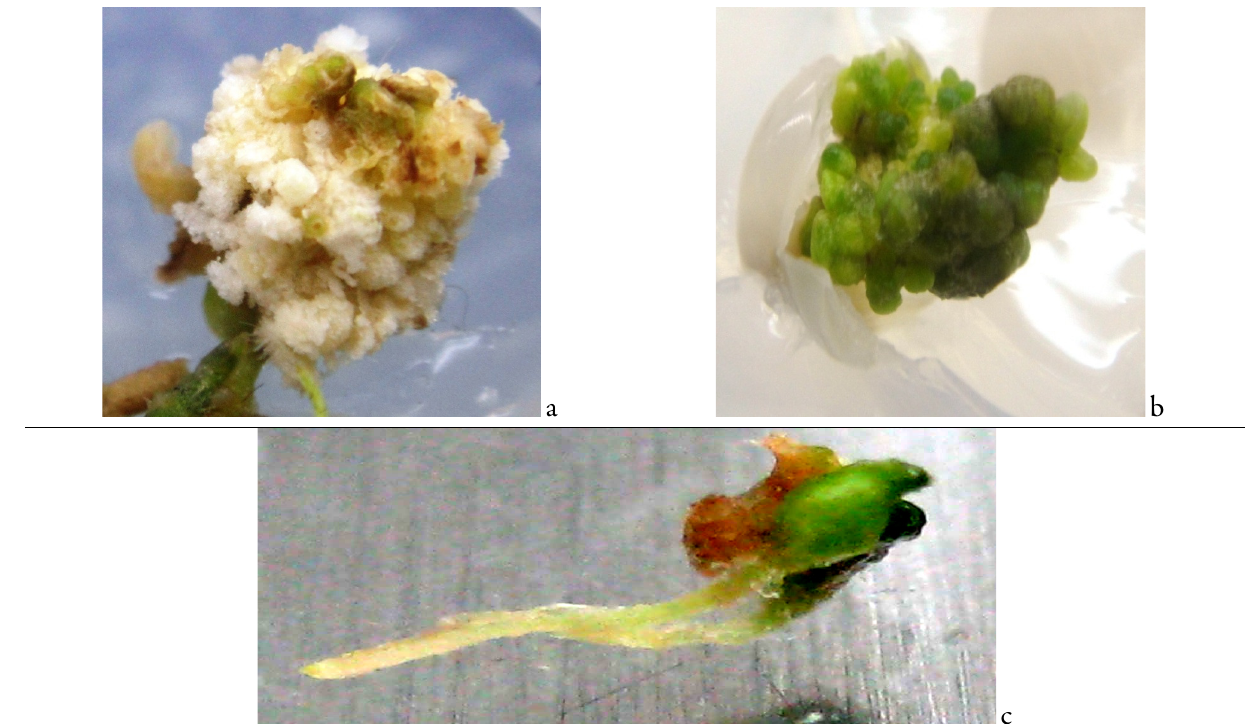
Fig. 1. (a) Tuber-callus induced on NAA (0.5 mg L -1 ) + BAP (0.5 mg L -1 ) added medium; (b) embryogenic callus with somatic embryos (arrows); (c) isolated somatic embryos with shoot and root ends (Bar 1a=3cm, 1b=4cm and 1c=2cm)